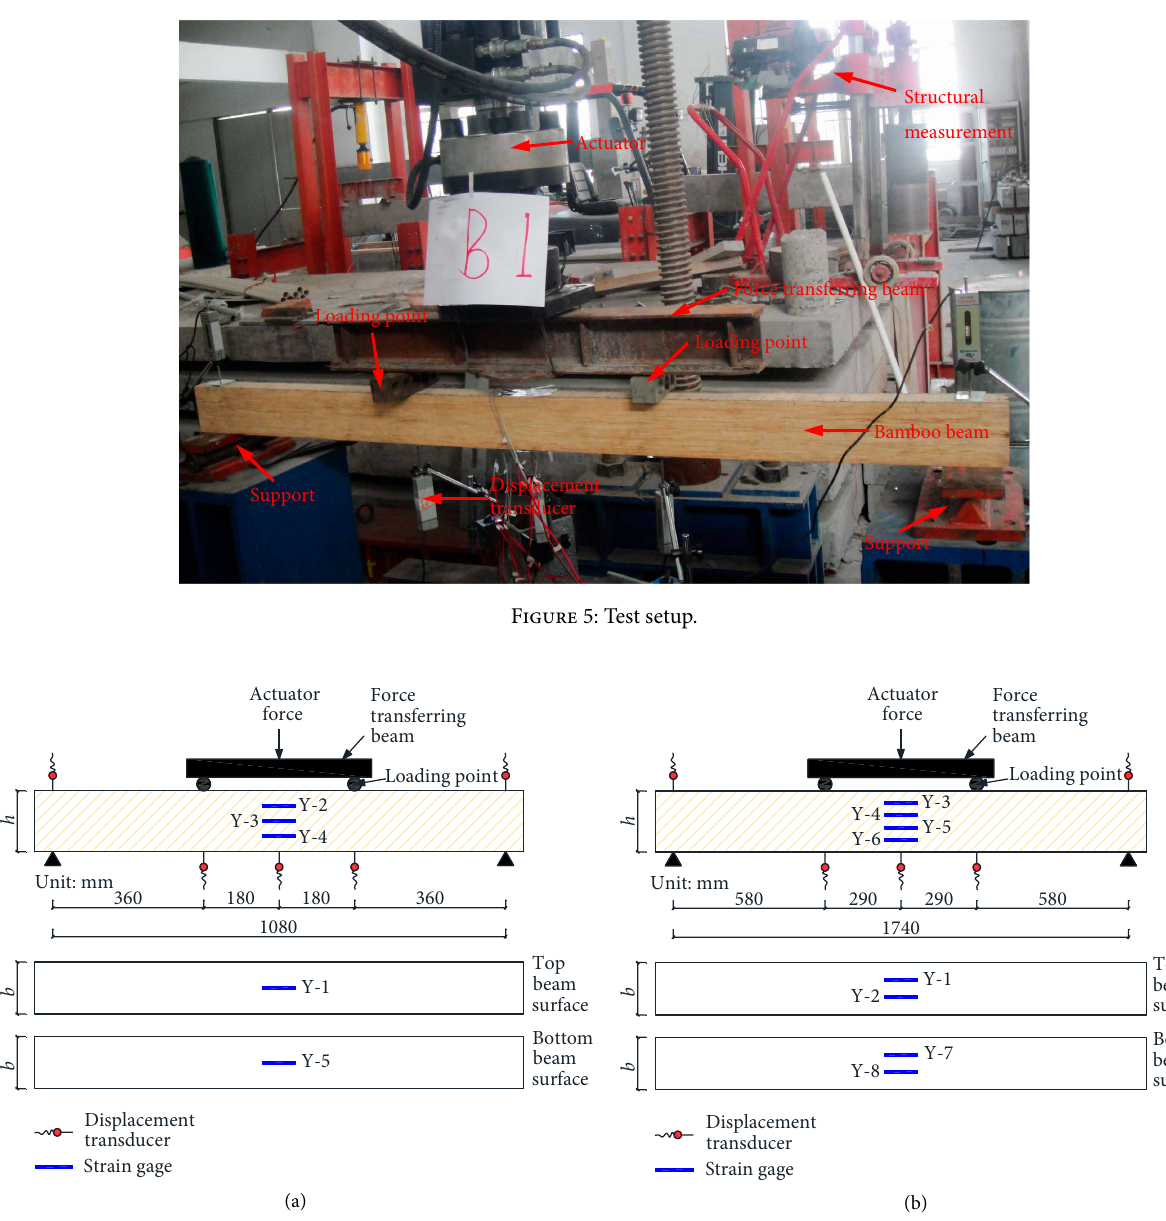
Figure 6: Layout of measurement equipment: (a) first series and (b) second